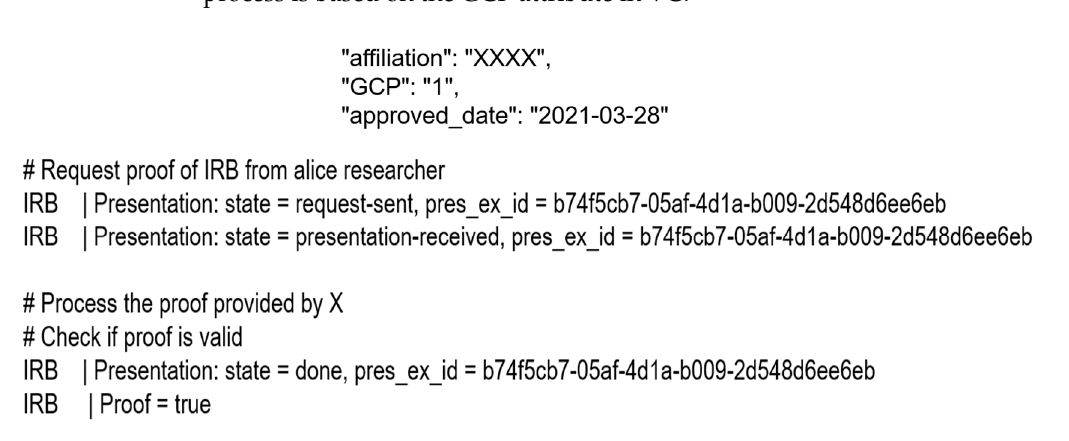
Figure 14. The proof.